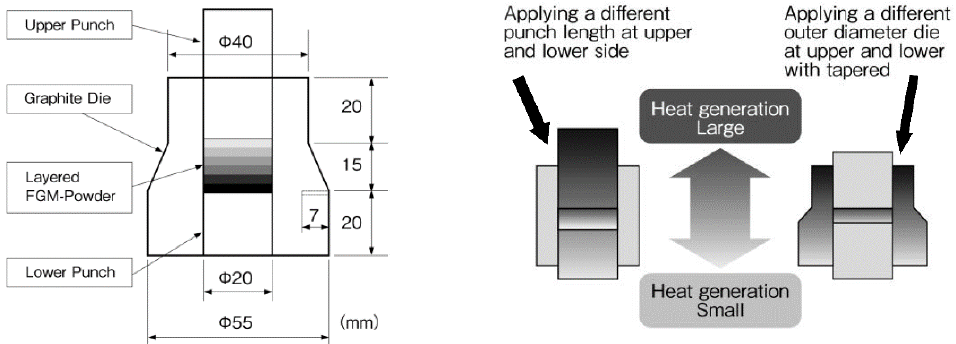
Figure 32. Die and punch assembly for SPS temperature gradient sintering.